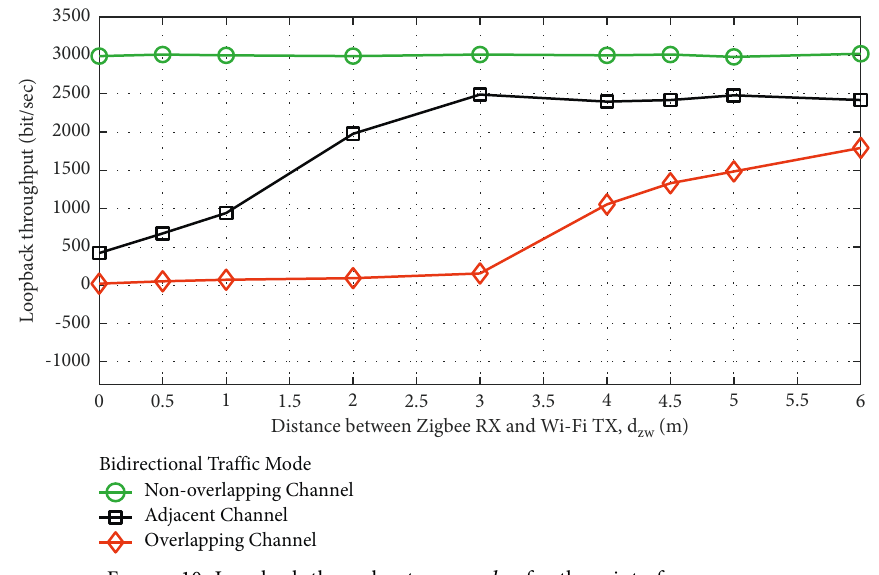
zw for three interference